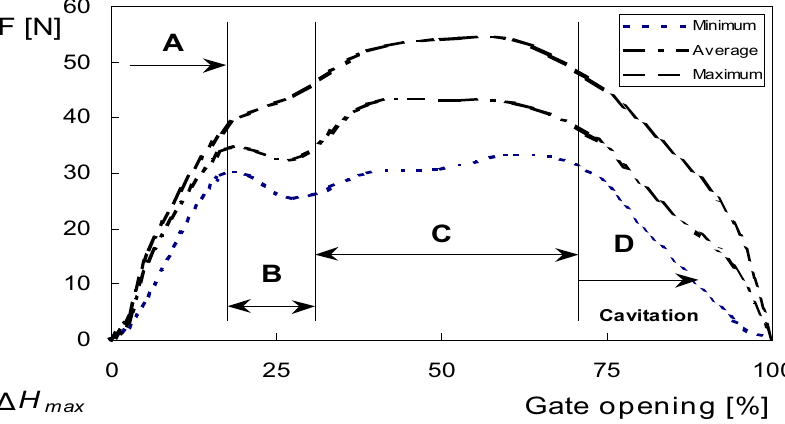
Fig. 9. Maximal, minimal and average values of the acting force in dependency of gate